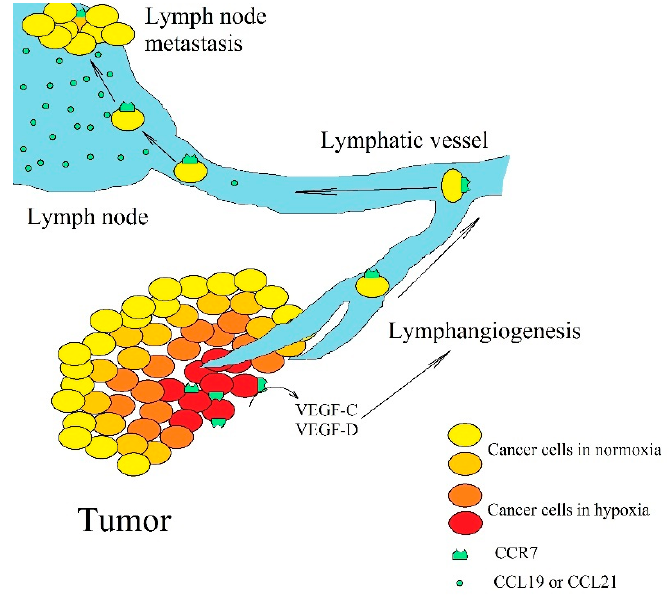
Figure 4. The significance of CCR7 expression in lymph node metastasis. Hypoxia increases CCR7 expression on cancer cells, which leads to an increase in VEGF-C and VEGF-D expression, which in turn, leads to lymphangiogenesis. Then, cancer cells enter lymphatic vessels where they migrate to lymph nodes. As lymph nodes have a high expression of CCL19 and CCL21, cancer cells with CCR7 expression become trapped and form metastasis there.